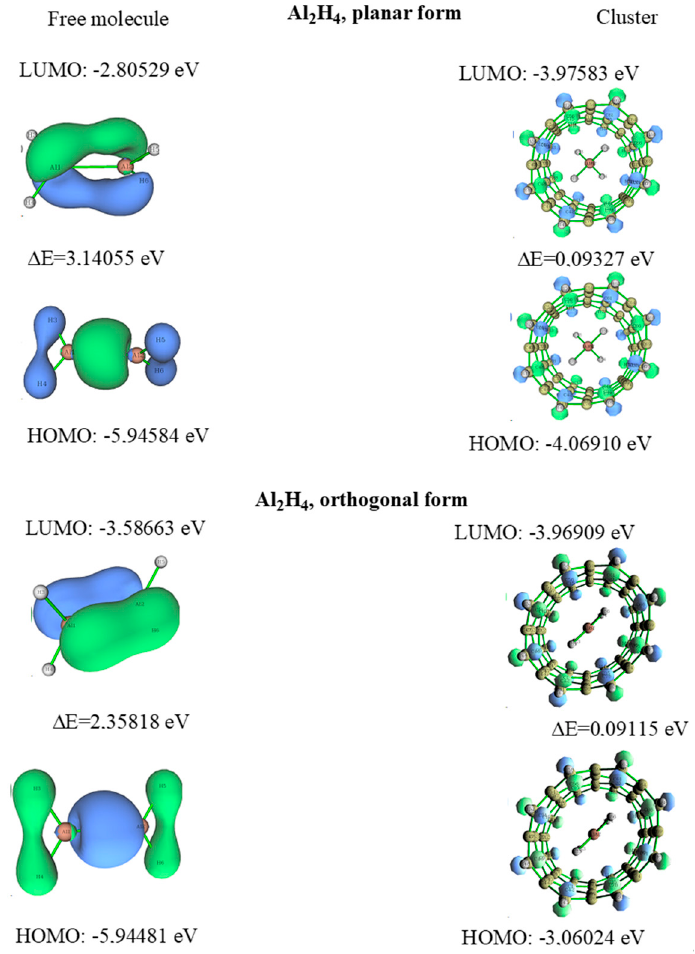
Figure 11. Differences in the energy of HOMO-LUMO of dialane (PBE/3 ζ ). Adapted with modification